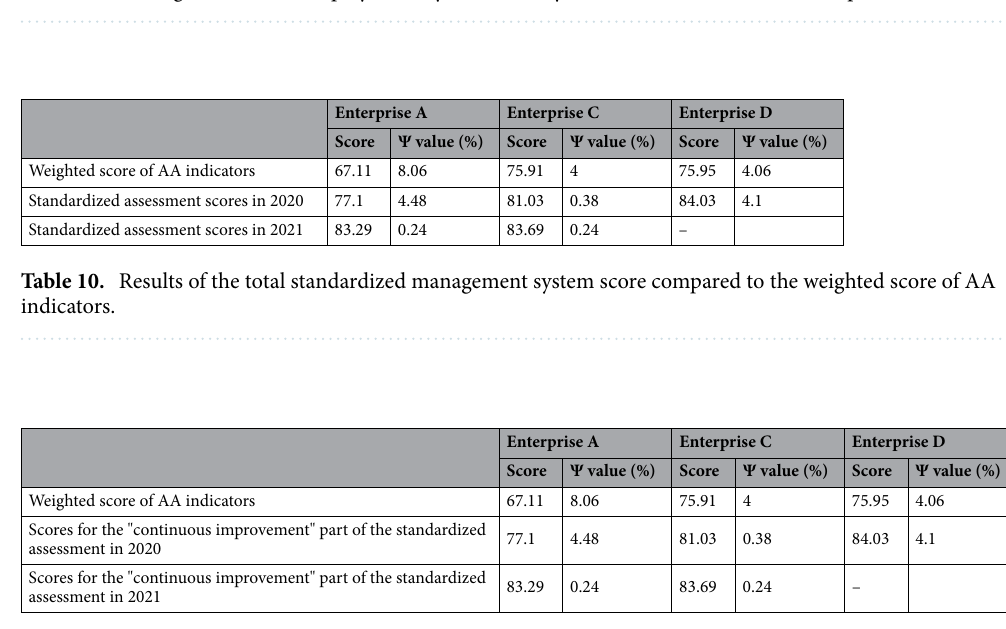
Table 9. Ranking of front-line employee safety status (subsystem C) scores of the three companies.